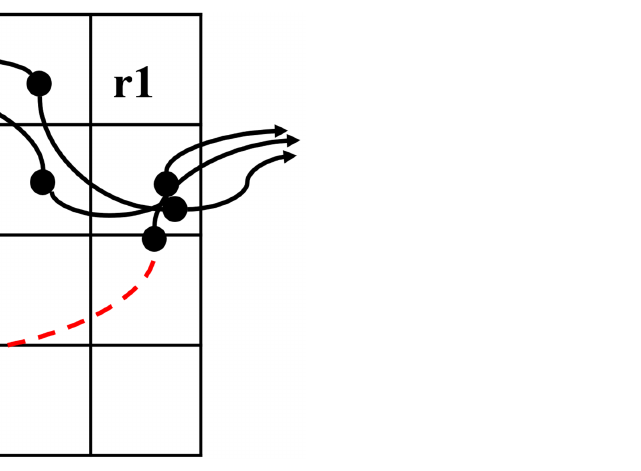
Figure 1. Schematic representation of the spatial offset of trajectory points. Given the motion trajec- tories of three moving objects and the fact that p1 is in a low-density region during motion, it can be suspected that there is a spatial offset of